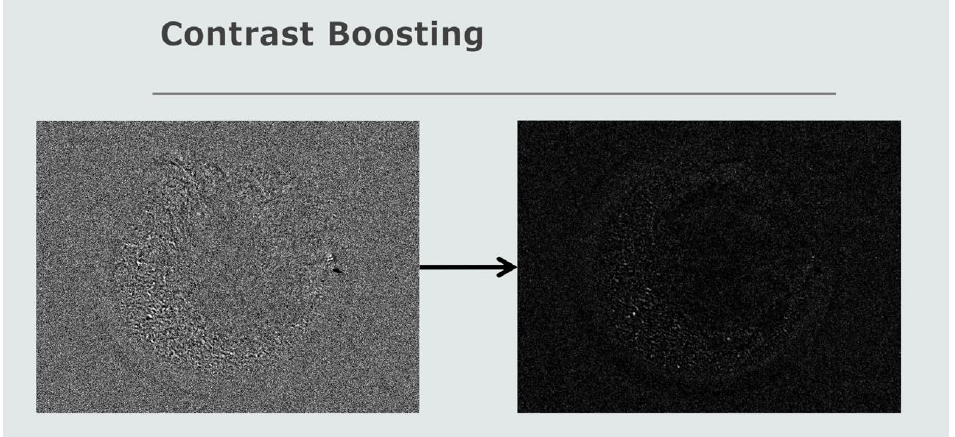
Figure 5. Contrast boosting can make these contours/artifacts/remnants more visibly apparent. Image collected from TE-300 inverted microscope, 400 × .